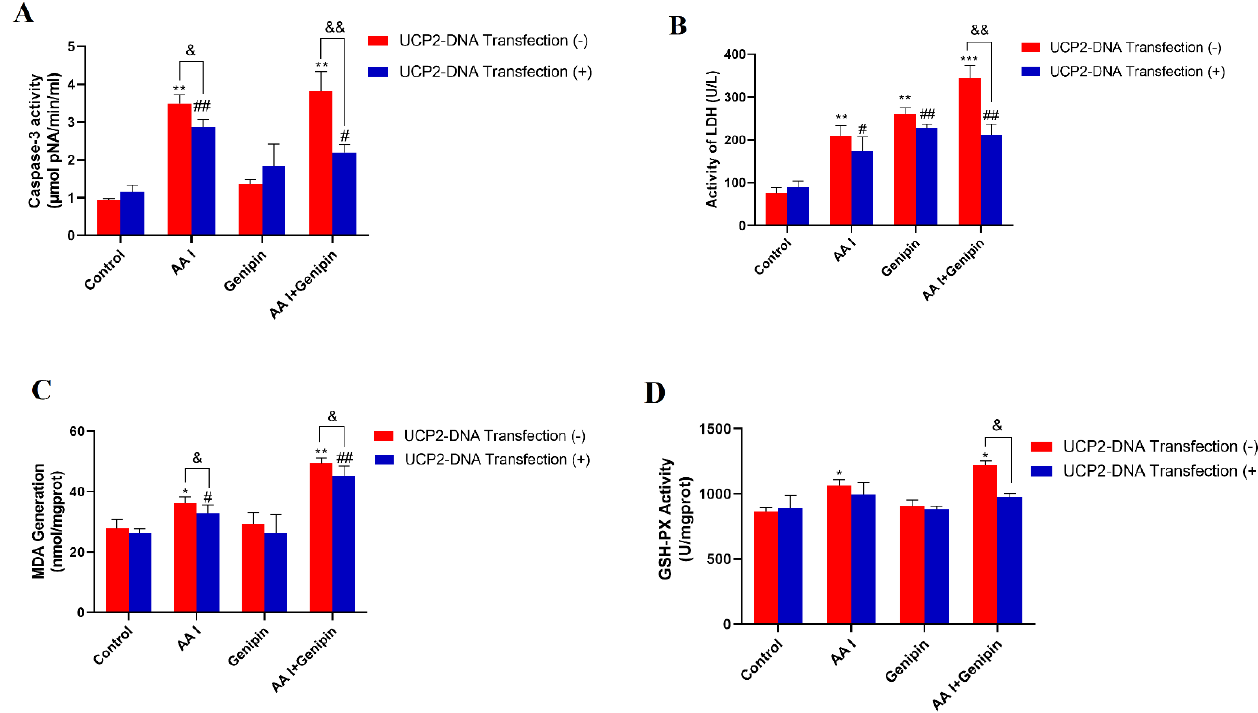
Figure 8. Increasing UCP2 expression alleviated AAI-induced apoptosis and oxidative stress. HK-2 cells with or without UCP2-DNA transfection were treated with 40 µ M AA I + 25 µ M genipin for 24 h. Caspase-3 activity ( A ), LDH activity ( B ), MDA generation ( C ) and GSH-Px activity ( D ) were detected on transfected or non-transfected cells. Each bar represents the mean ± SD of three independent experiments (* p < 0.05; ** p < 0.01; *** p < 0.001 vs. UCP2-DNA Transfection ( − ) Control group; # p < 0.05; ## p < 0.01 vs. UCP2-DNA Transfection (+) Control group; & p < 0.05; && p < 0.01).